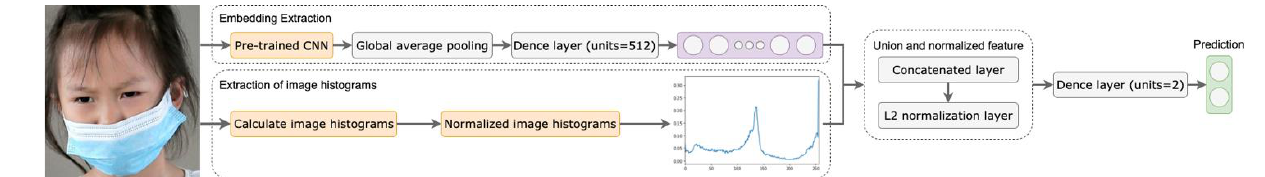
Figure 1. A diagram of the proposed method for facial mask